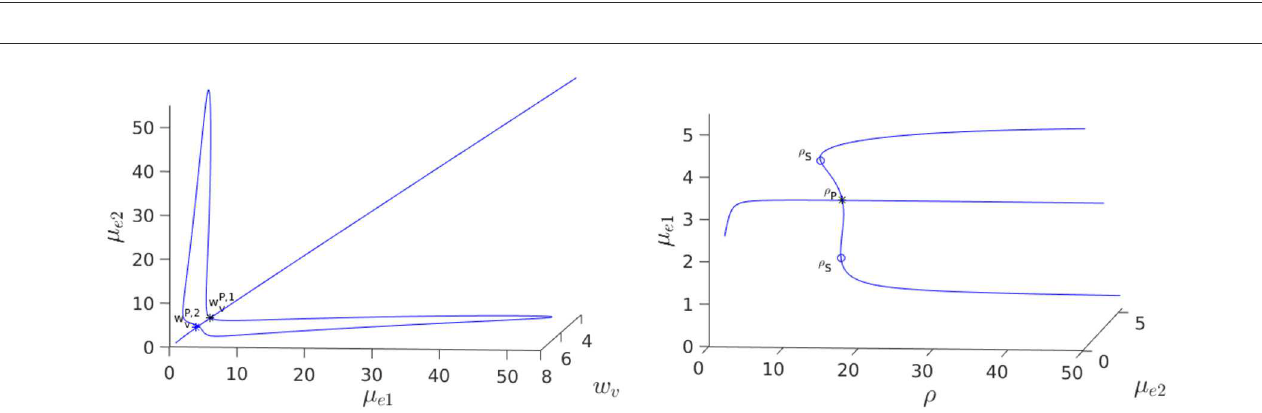
0, which is equivalent to Equation (4.6), no longer holds for any ρ > 0. =